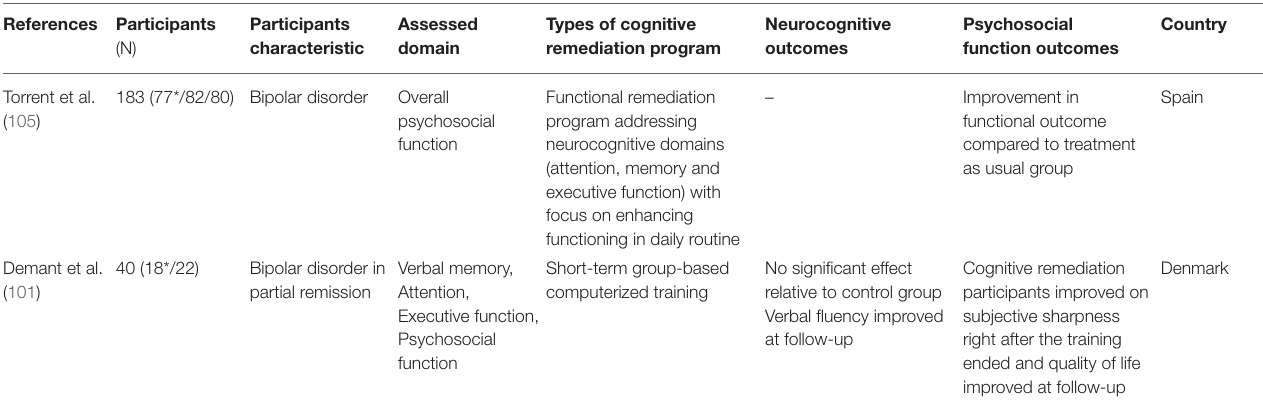
TABLE 4 | RCT studies on CR effect on bipolar